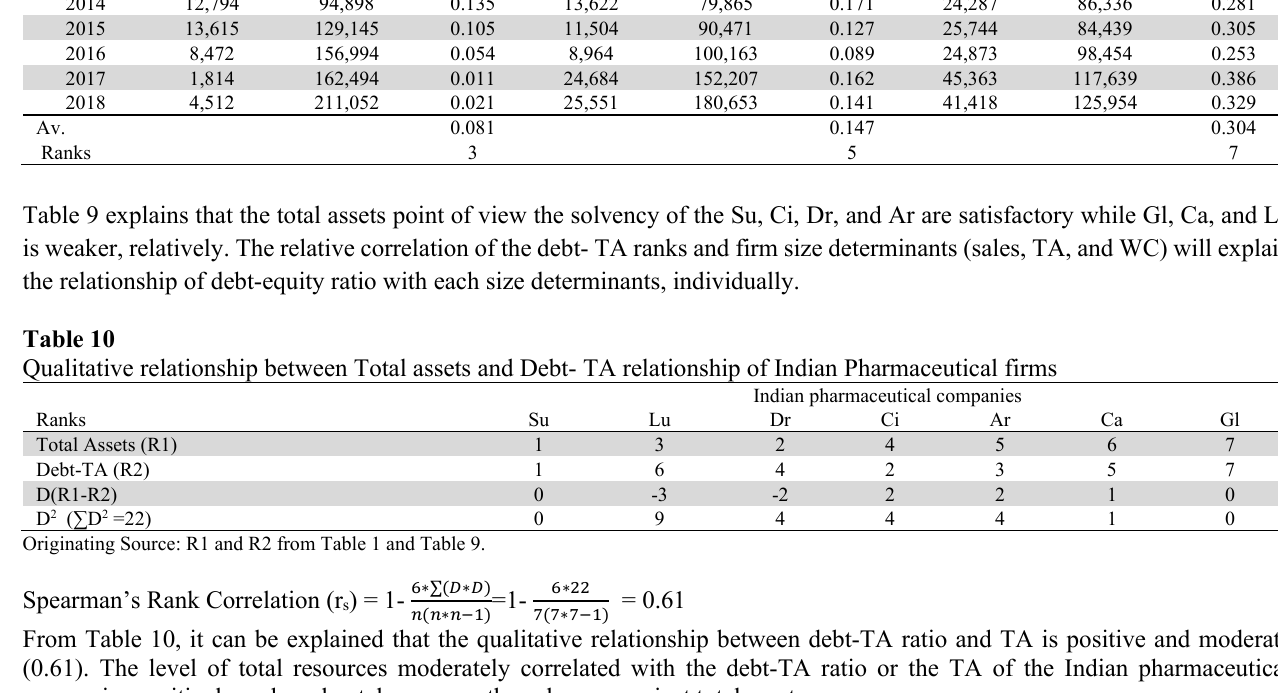
From Table 10, it can be explained that the qualitative relationship between debt-TA ratio and TA is positive and moderate (0.61). The level of total resources moderately correlated with the debt-TA ratio or the TA of the Indian pharmaceutical companies positively and moderately governs the solvency against total assets. Table 11 Qualitative relationship between WC and Debt- TA relationship of Indian Pharmaceutical firms Indian pharmaceutical companies Ranks Su Lu